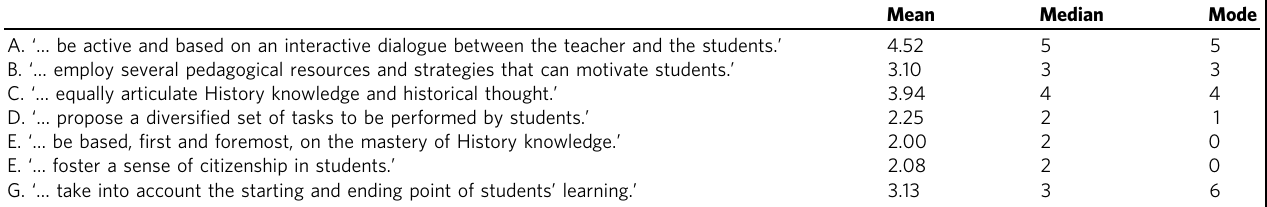
Table 3 Descriptive statistical measurements summary regarding question 1 about ‘ History Class must …’